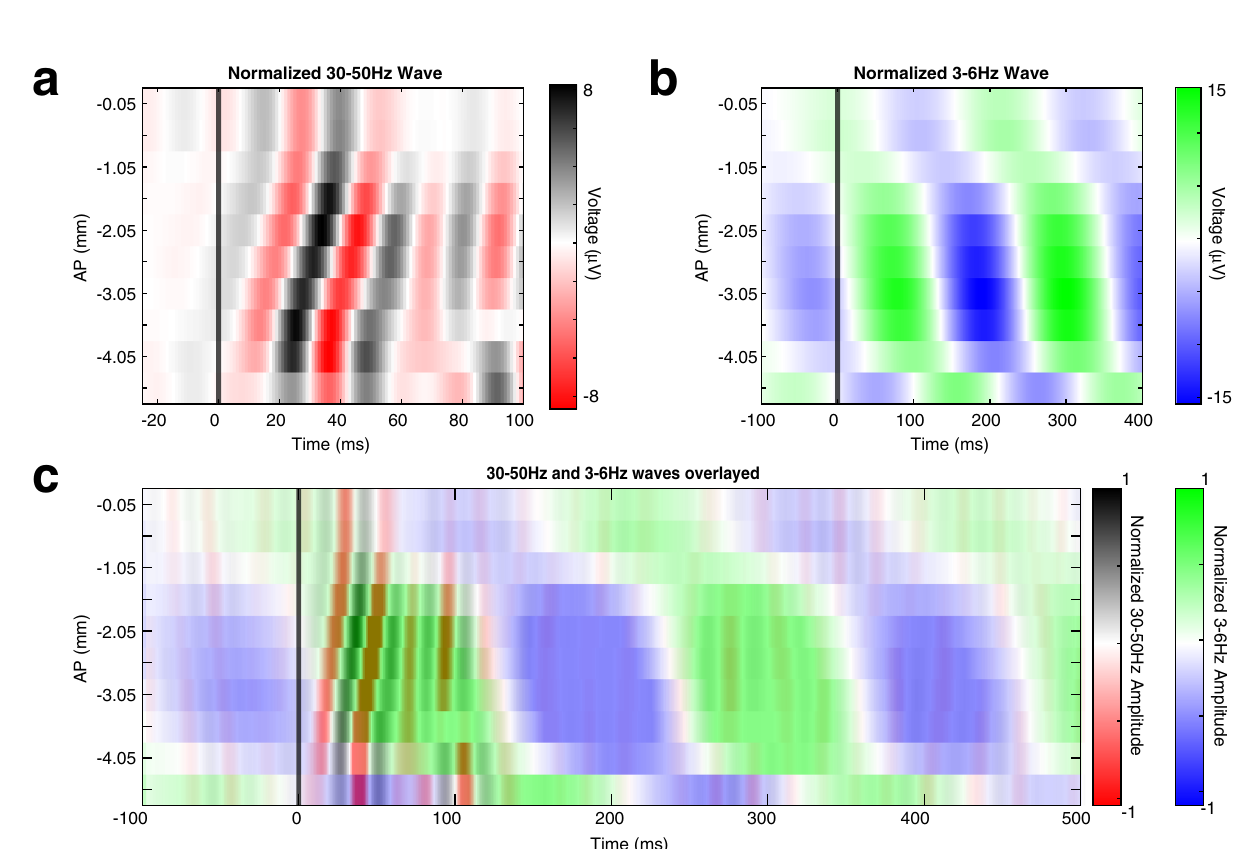
Fig.2|Average fi lteredLFPillustratetravelingwave-likebehavior.a Averageof theVEP fi lteredat30 – 50Hzfrom10electrodesalongtheanteriortoposterioraxis ( − 2.25mmML) in a representative mouse. The x axis denotes time relative to sti- mulus onset, the y axis indicates AP position of an electrode relative to bregma. Note evoked high frequency waves starting at − 4.05mm from bregma (V1) and traveling anteriorly over ~100ms. b Average of the VEP fi ltered at 3 – 6Hz from the